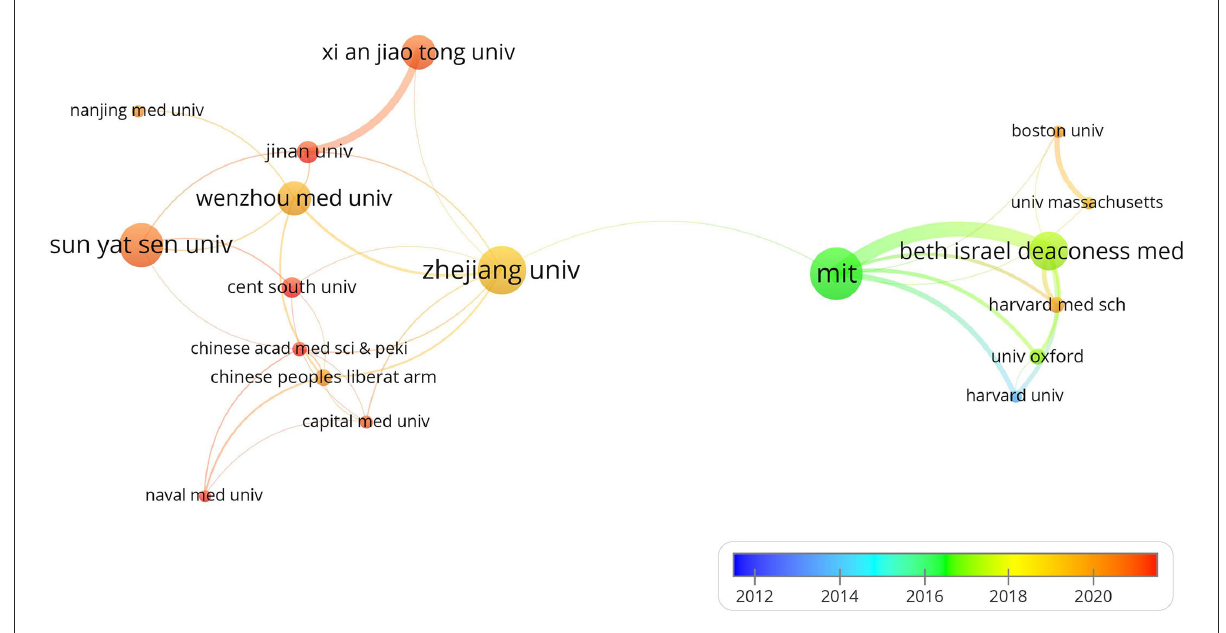
FIGURE2 The network of co-institute.